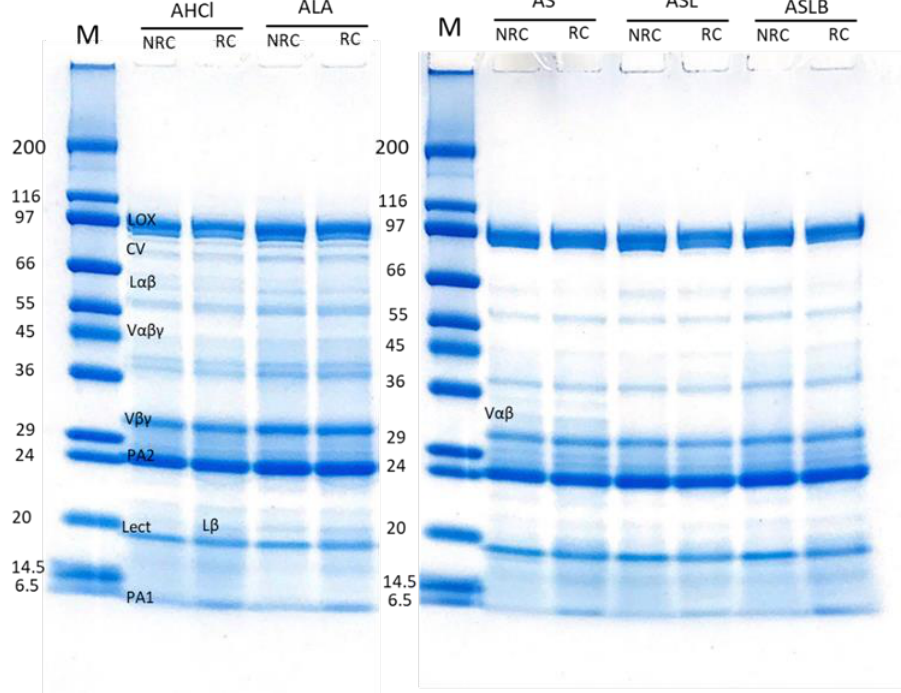
Figure 7. Electrophoretic profiles of albumin fractions obtained by controls (AHCl, ALA) and fer- mentations (AS, ASL, ASLB) in reducing (RC) and non-reducing (NRC) conditions. Clearly absent in the previous patterns, the main 2S albumin subunits (PA2, ~26kDa; PA1, ~6kDa) [10,62] were observed in the electrophoretic profiles of albumin-rich samples,